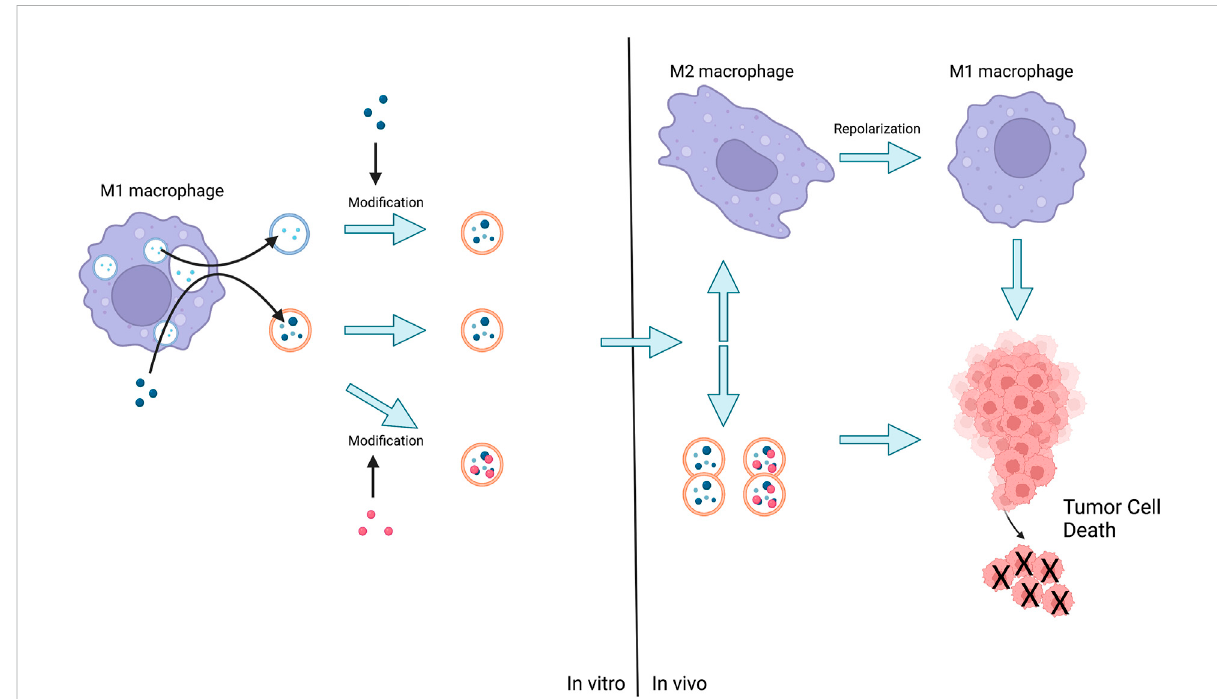
FIGURE 4 ThemethodofactionofM φ s-EVsiseitherthereleaseofEVsbyM1followedbytheadministrationoftheloadeddrug,orthestimulationofM1by the advance administration of the drug and the subsequent production of EVs for direct action or further modi fi cation. Eventually EVs act on tumor cells or act on M2 leading to their repolarization and then act on tumor cells leading to their